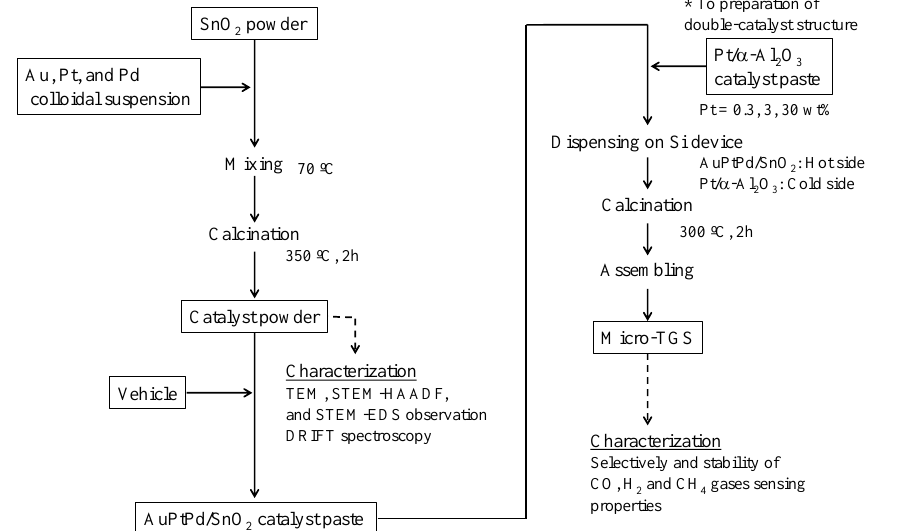
Figure 1. Schematic representation of the AuPtPd/SnO 2 catalyst powder and micro thermoelectric gas sensor (micro-TGS) preparation.